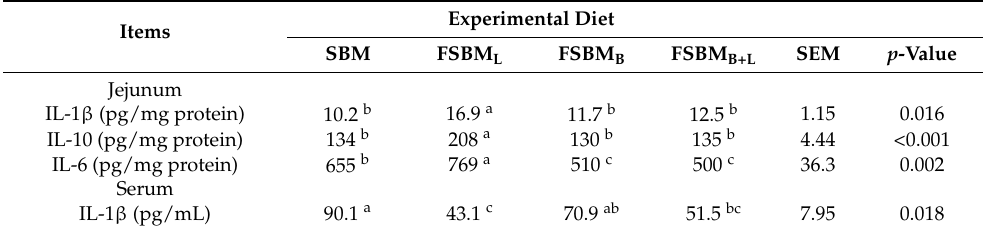
Table 5. Effect of two-stage FSBM on serum and jejunum’s immunity of 35 day-old broilers 1 .